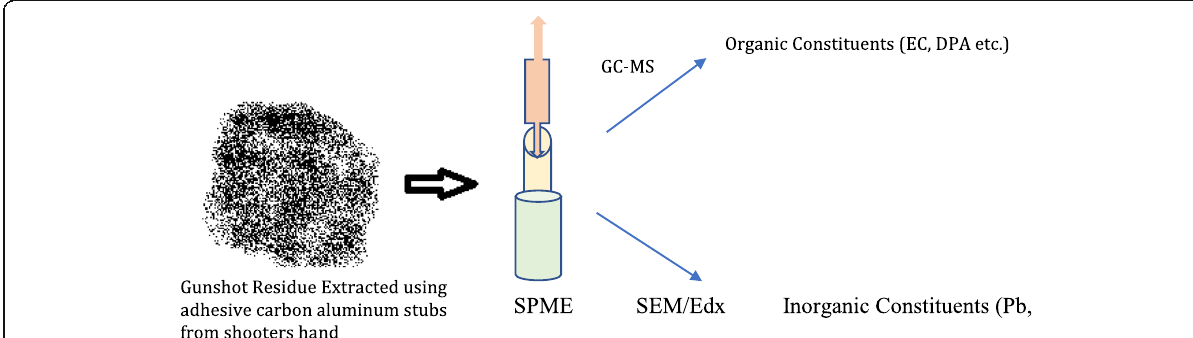
Fig. 4 Gunshot residue analysis technique using solid-phase micro extraction. SPME, Solid-phase microextraction; EC, ethyl centralite; DPA, diphenyl